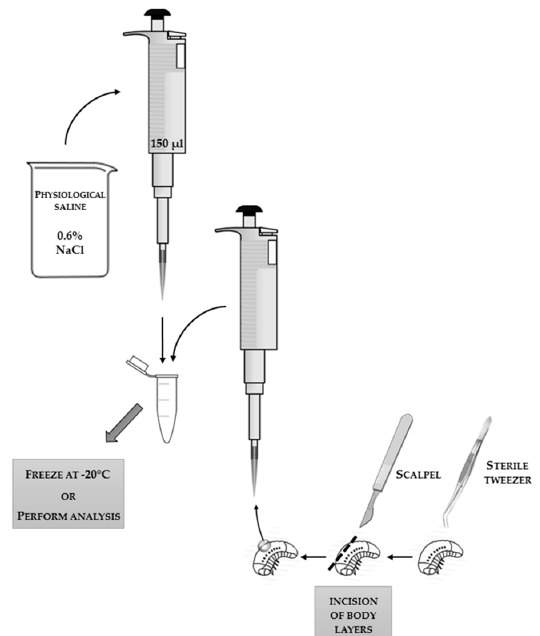
Figure 2. The scheme of the technique of collecting hemolymph flowing out of the insect’s body after incision of the insect’s body surface with a scalpel. The applied tools and reagents, along with the used volumes, are presented in the scheme.